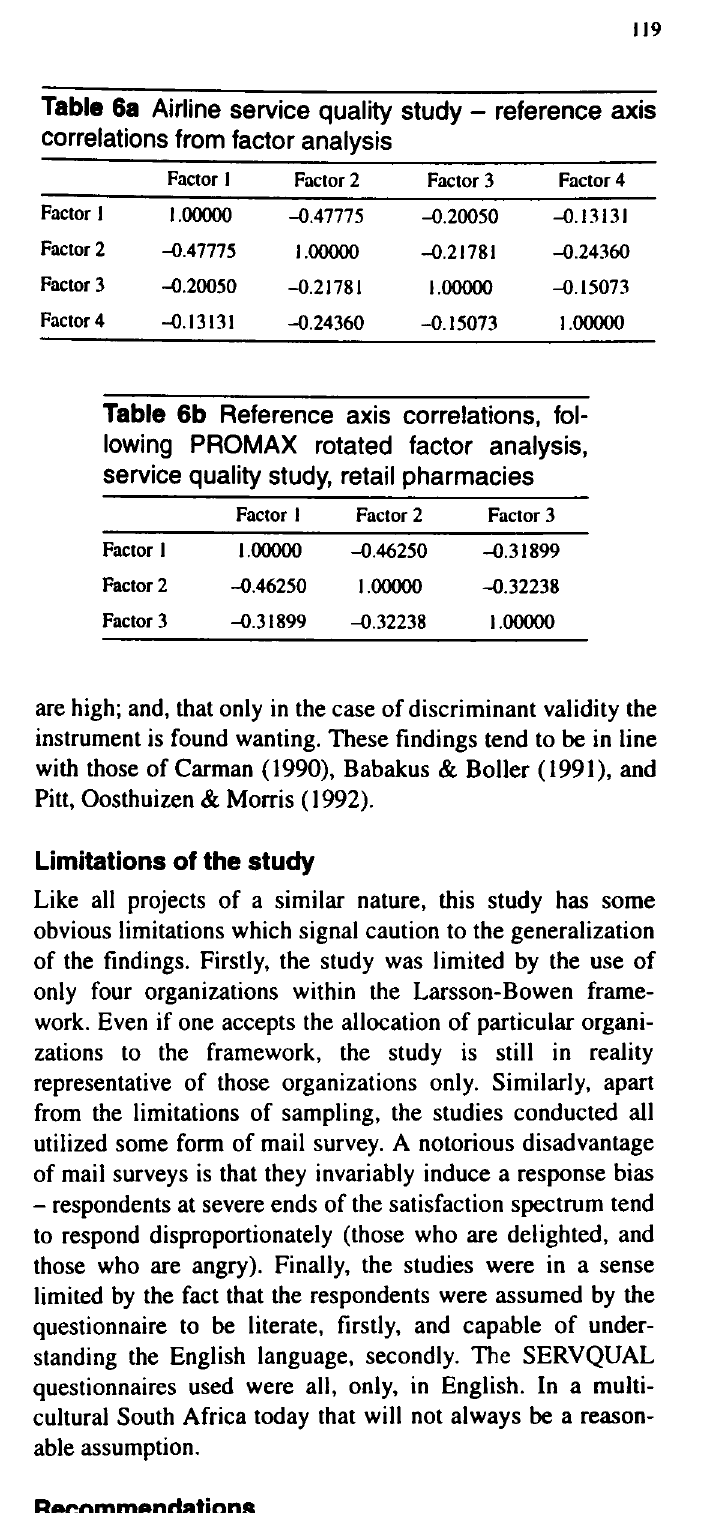
Table &a Airline service quality study - reference axis correlations from factor analysis